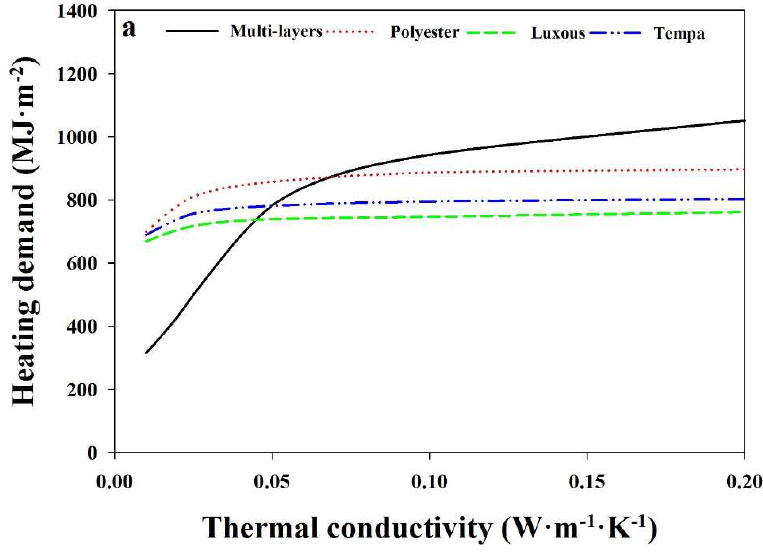
Table 8. Calculated heating demand with the material’s